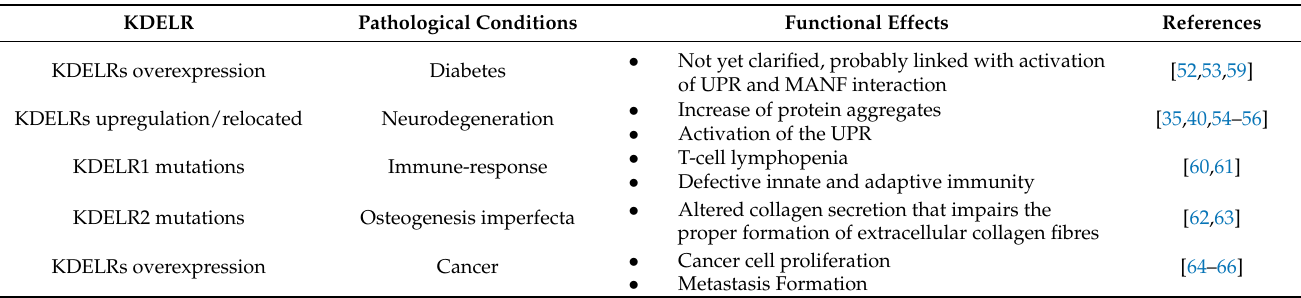
Table 1. Pathological conditions associated with